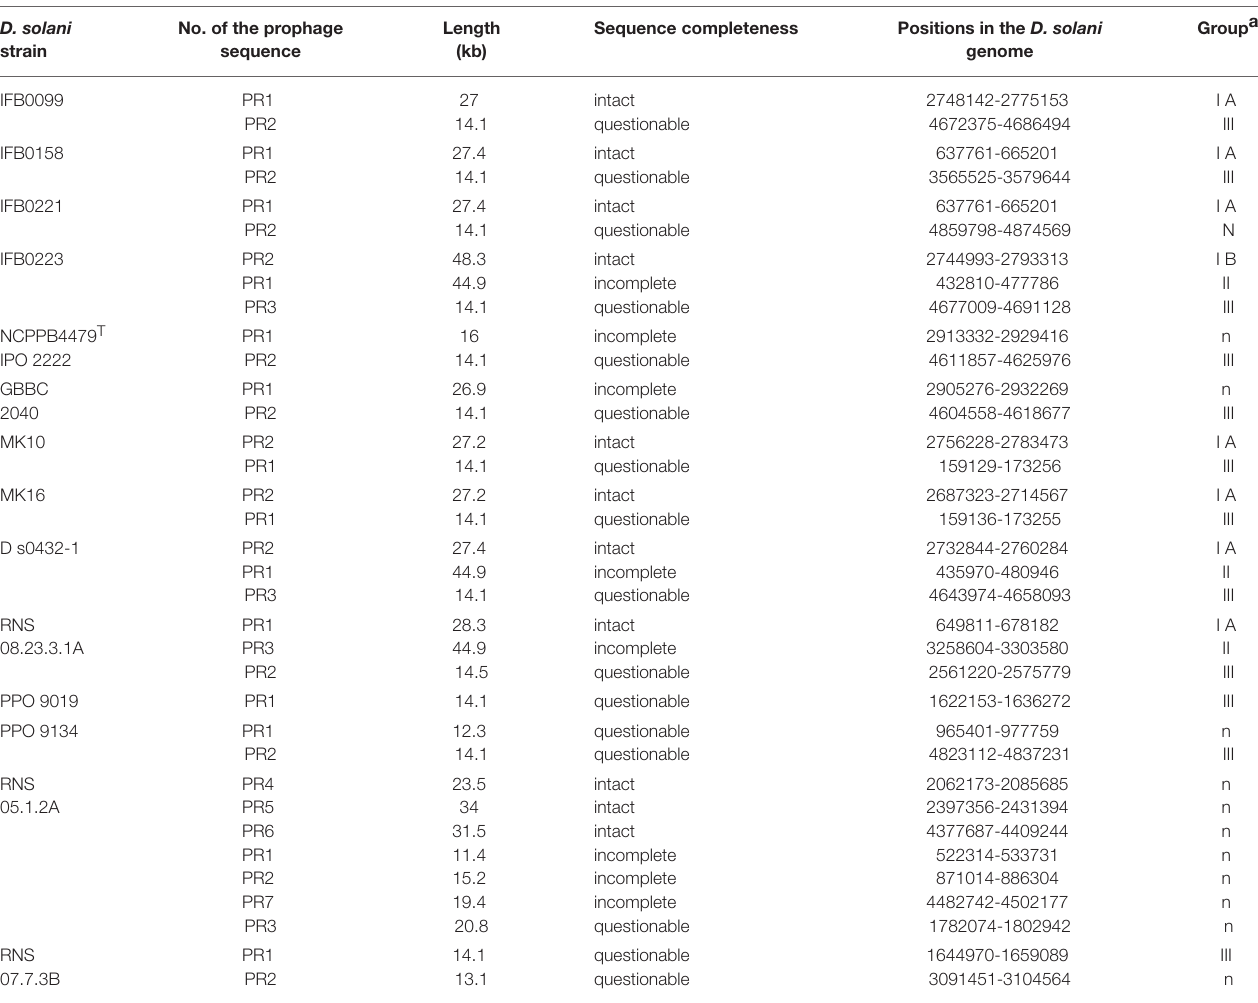
TABLE 3 | Prophages present in the analyzed D. solani genomes. D. solani